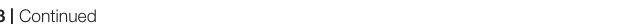
FIGURE 8 | Continued tissues from different groups. Scale bar: 50 µ m. Panel (E) is the summary of mean ± SD of KI-67 + cell fractions per high microscope field ( × 400) in the tumor tissues from four mice of each group. *** p < 0.001, compared with the PBS control treatment mice using unpaired t -test. (F,G) Large amounts of senescent tumor cells were observed in the tumor tissues from both treatments of baicalein and baicalin in NSG mice. SA- β -Gal expression was determined in the tumor frozen tissues from different groups at the endpoint of experiment. Panel (F) is photomicrographs of SA- β -Gal expression in tumor tissues from different groups as arrows indicated. Panel (G) is the summary of mean ± SD of SA- β -Gal + cell numbers per high microscope field ( × 400) in the tumor tissues from four mice of each group. *** p < 0.001, compared with the PBS treatment control mice using unpaired t -test. (H,I) Increased apoptotic cells were observed in B16F0 tumor tissues from the treatment groups with baicalein and baicalin. Cell apoptosis in the frozen sections was analyzed by the anti-cleaved caspase-3 staining at the end of experiments. Panel (H) are representative images of cleaved caspase-3 expression in tumor tissues from different groups. Scale bar: 50 µ m. Panel (I) is the summary of mean ± SD of cleaved caspase-3 + cell fractions per high microscope field ( × 400) in the tumor tissues from four mice of each group. *** p < 0.001, compared with the PBS treatment control group using unpaired t